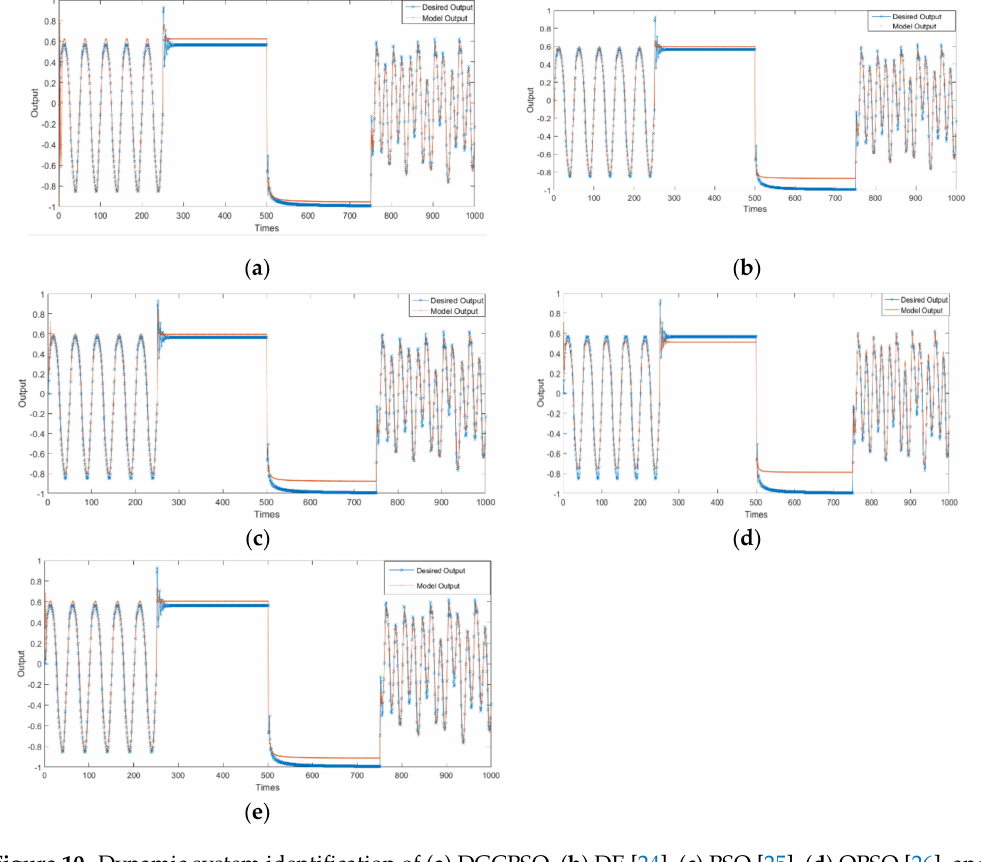
Figure 10. Dynamic system identification of ( a ) DGCPSO, ( b ) DE [24], ( c ) PSO [25], ( d ) QPSO [26], and ( e ) CPSO [27].